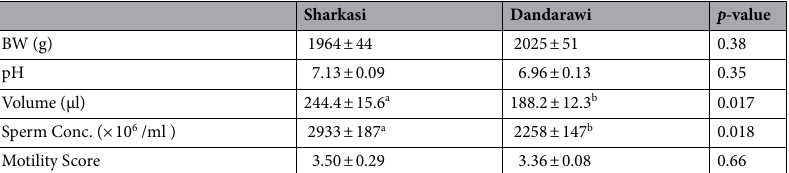
Table 1. Rooster body weight, semen pH, ejaculate volume, sperm concentration, subjective motility, and motility score in Sharkasi and Dandarawi strains. Means ± SEM was used to express all measurements. Ten roosters each strain were weighed. Semen samples (n = 5 per rooster) were collected over a period of 10 days and evaluated for physical characteristics. a,b For main effects, means within a row without common superscripts differ significantly ( p <